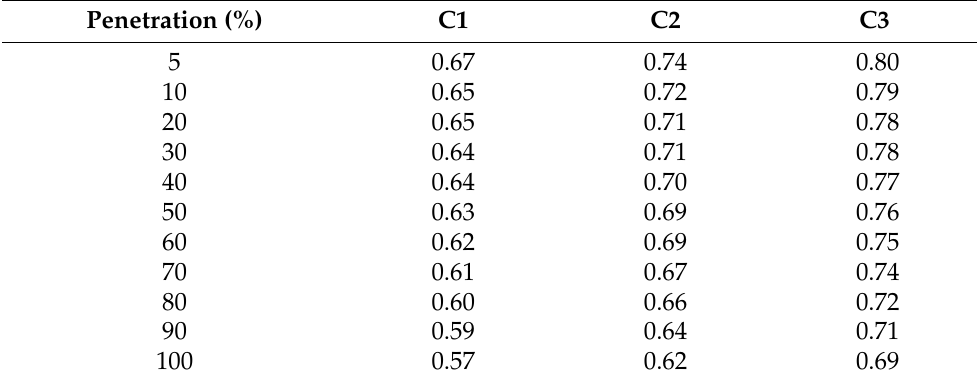
Table 4. Normalized average charging rate for the droop controlled scenarios (C1–C3).